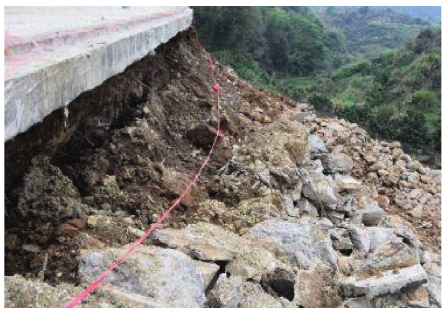
Figure 3: Actual pavement structure with